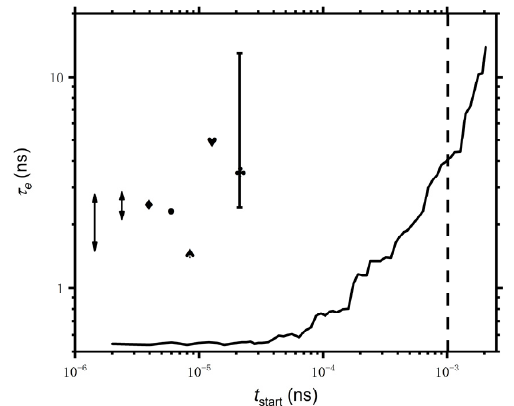
Figure 7. Dependence of 𝜏 (cid:3032) of PE model on the start time, 𝑡 (cid:3046)(cid:3047)(cid:3028)(cid:3045)(cid:3047) , which means the data of 𝐺(𝑡 < 𝑡 (cid:3046)(cid:3047)(cid:3028)(cid:3045)(cid:3047) ) are discarded. 𝜏 (cid:3032) from Table 2 in Ref [13] are shown on left side. The vertical dash line indi- are discarded. τ e from Table 2 in Ref. [13] are shown on left side. The vertical dash line indicates the cates the end of the bond length relaxation. end of the bond length